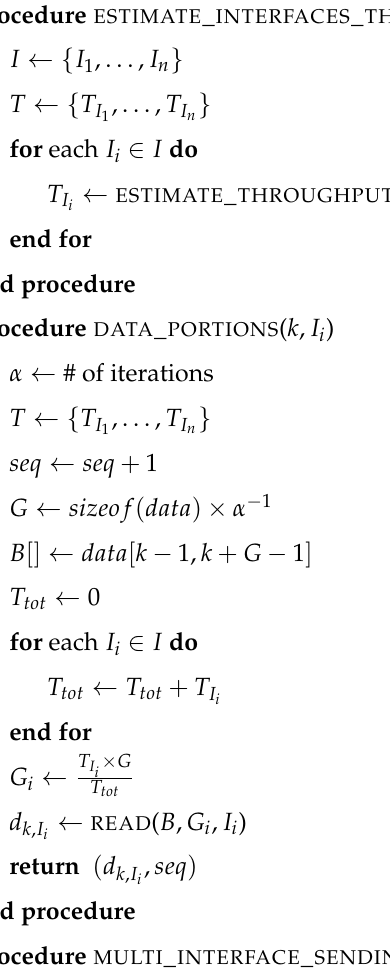
Algorithm 1 Pseudo-code AUTO